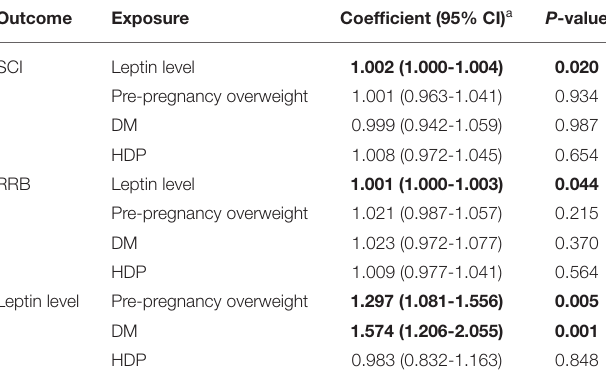
TABLE 1 | Sample characteristics of participating children and their parents.